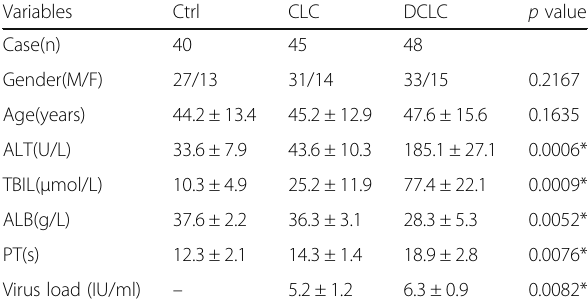
Table 1 Clinico-pathological information of